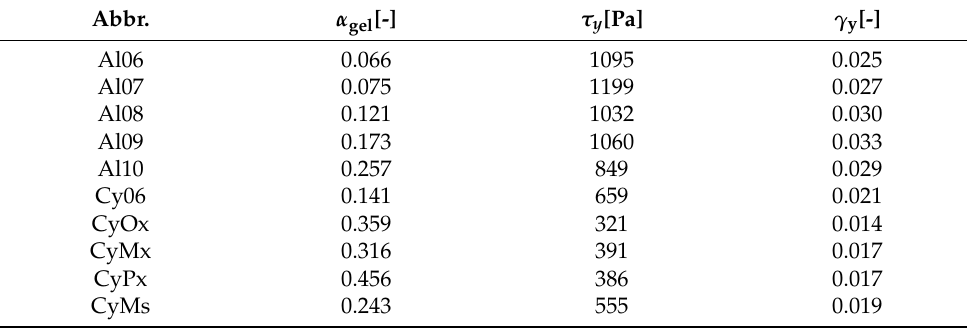
Table 5. Property of 12HSA organogels obtained at x = 2.8 mol%.